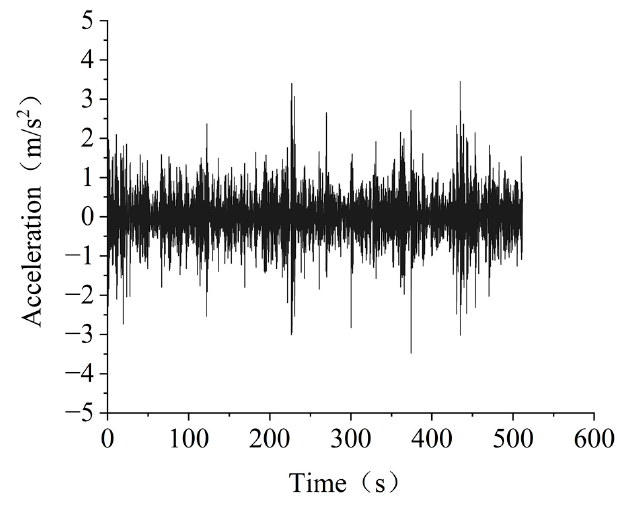
Figure 11. Acceleration diagram of transmission tower under ABL wind.